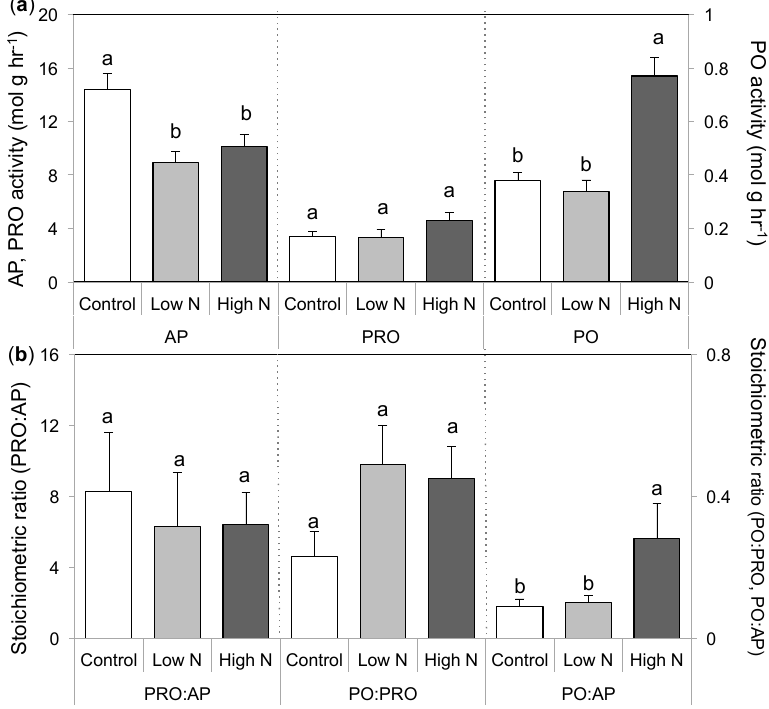
Figure 2. Mean levels of ( a ) acid phosphatase, protease, and phenol oxidase activity; and ( b ) enzymatic stoichiometric PRO:AP, PO:PRO, and PO:AP in ectomycorrhizal communities in control and N-fertilized plots. Vertical bars indicate the standard error of the mean; for each enzyme (or ratio), columns with the same letter do not differ significantly at p < 0.05 based on Tukey’s HSD test.